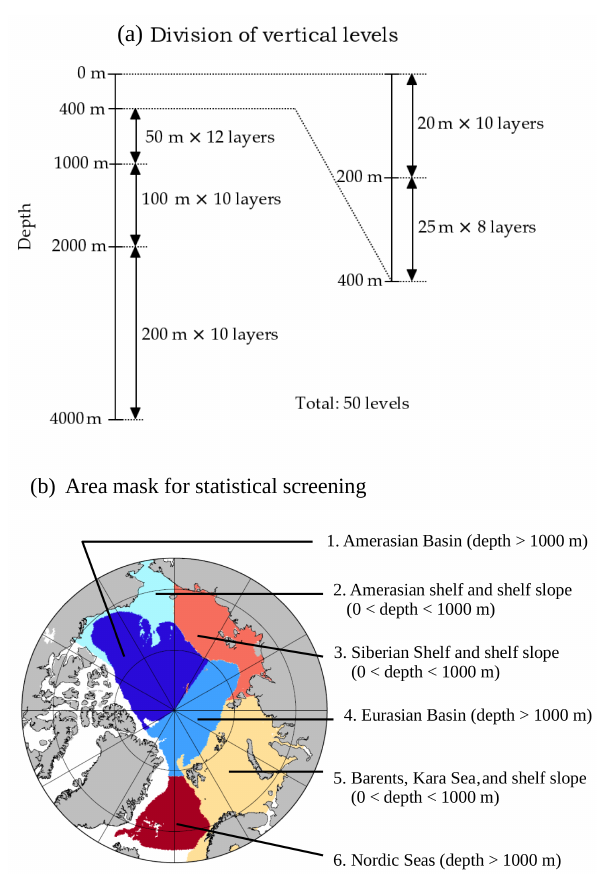
Figure 2. (a) Division of vertical levels for the statistical screen- ing and decorrelation scale examination. The archived TS data are classified into 50 levels according to their measurement depth. Data from an identical CTD profile are averaged over each depth range and regarded as one measurement. (b) Area mask for the area-based statistical screening and the decorrelation scale